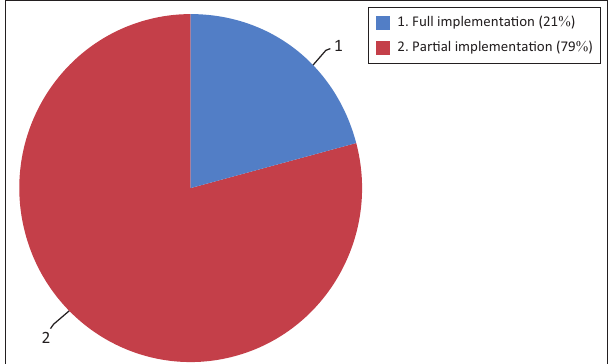
Figure 3 indicates the level of calculating RC for credit, market and operational risk in banks.